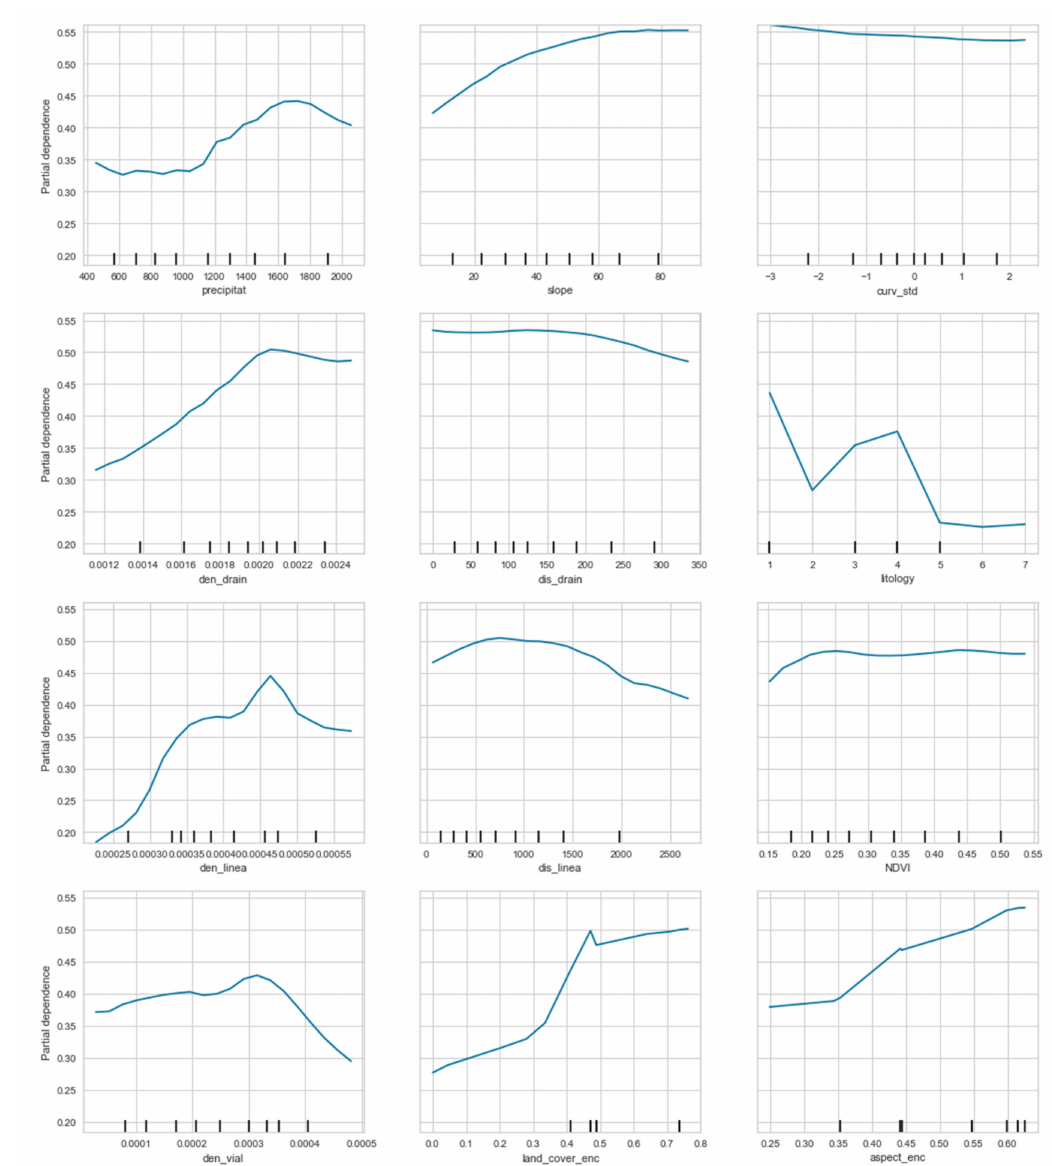
Figure 8. Partial dependencies between the explanatory variables and the variable to be explained (see text for